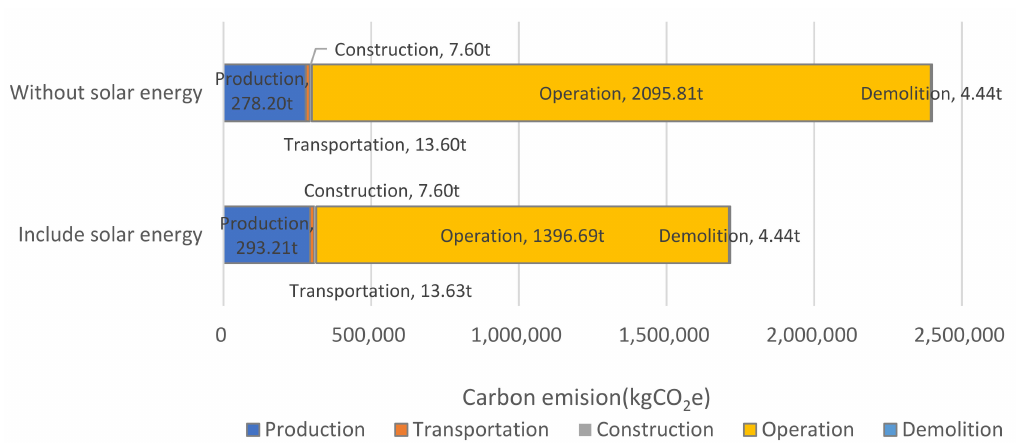
Figure 10. Carbon emissions before and after the solar photovoltaic system applied in refurbish- ment